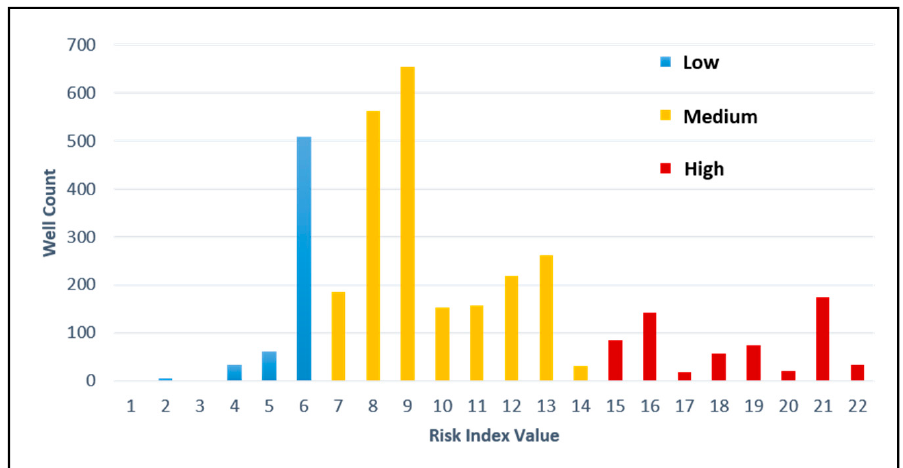
Figure 7. Number of wells for each risk index value. Higher risk index values imply higher risk and susceptibility for saltwater intrusion into the number of wells in each specific class. Low-risk classes are color-coded in blue, medium-risk classes in yellow and high-risk classes in red.